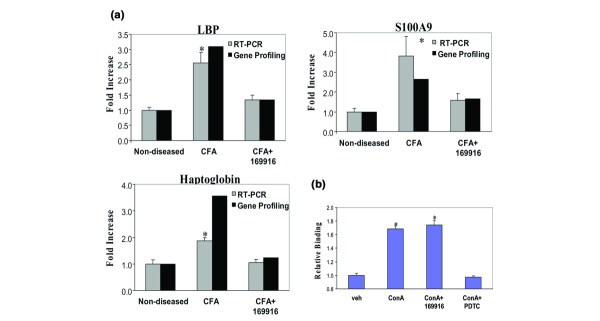
The effect of WAY-169916 in spleen cells. (a) The regulation of LBS binding protein (LBP), haptoglobin and S100A9 gene expression by WAY-169916 from spleens from the rat adjuvant model were confirmed by real-time RT–PCR (grey bars) compared with the regulation observed in the gene-profiling experiments (black bars). Results are expressed as means ± SEM from six rats per group. *P < 0.05 compared with vehicle control. (b) Treatment with WAY-169916 does not interfere with the binding of NF-κB to DNA. Nuclear extracts from primary mouse spleen cell cultures were co-treated for 18 hours with vehicle or concanavalin A (ConA; 5 μg/ml) and either WAY-169916 (1 μM) or pyrrolidine dithiocarbamate (PDTC) (100 μM) as indicated. CFA, complete Freund's adjuvant.